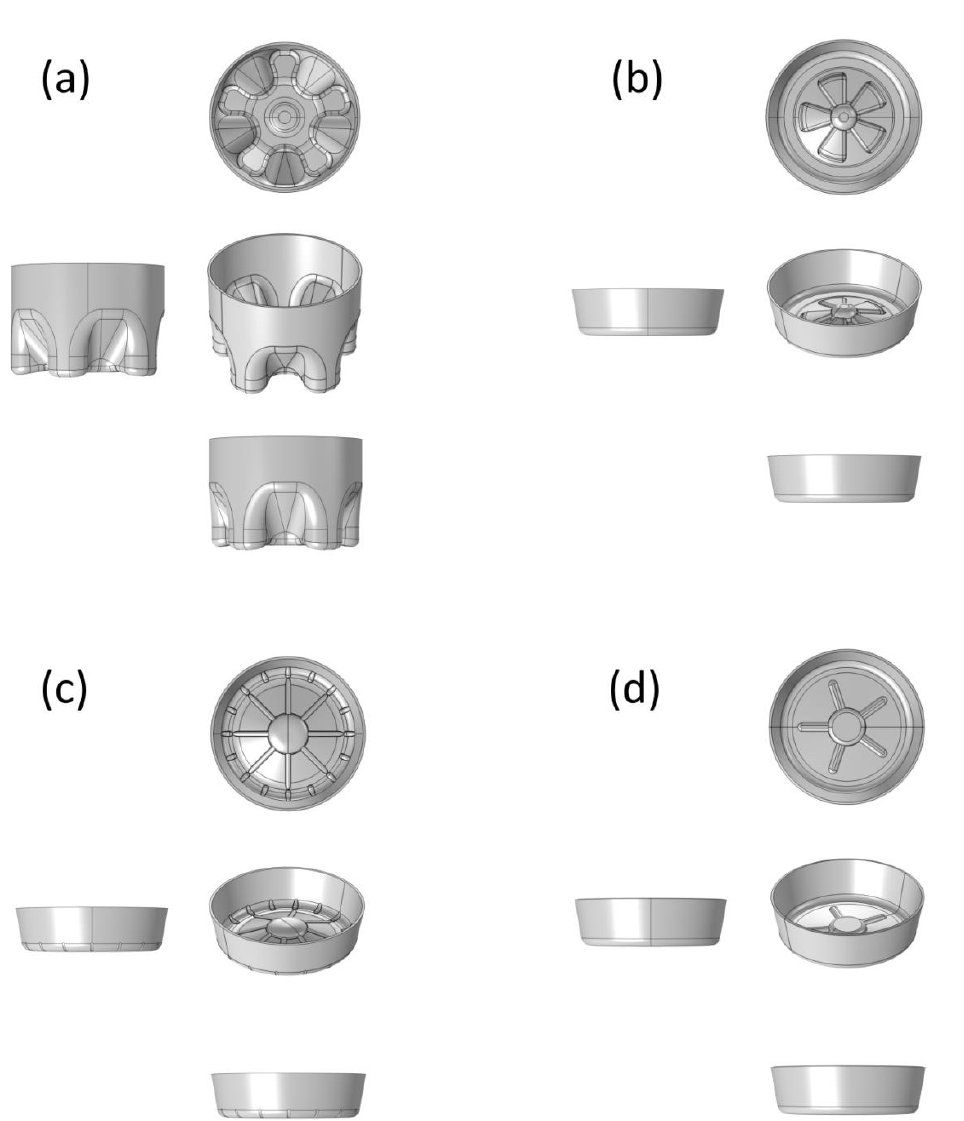
Figure 1. Diagram of CF-bottom ( a ), PP-bottom ( b ), PR-bottom ( c ) and OR-bottom ( d ) structure models.